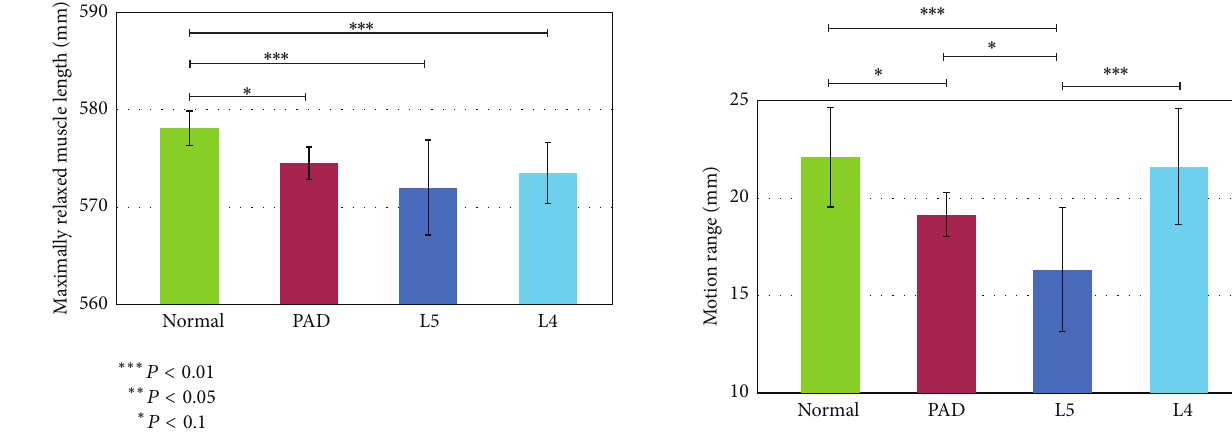
Figure 10: Maximally relaxed muscle length of the quadriceps muscle from the reference model.